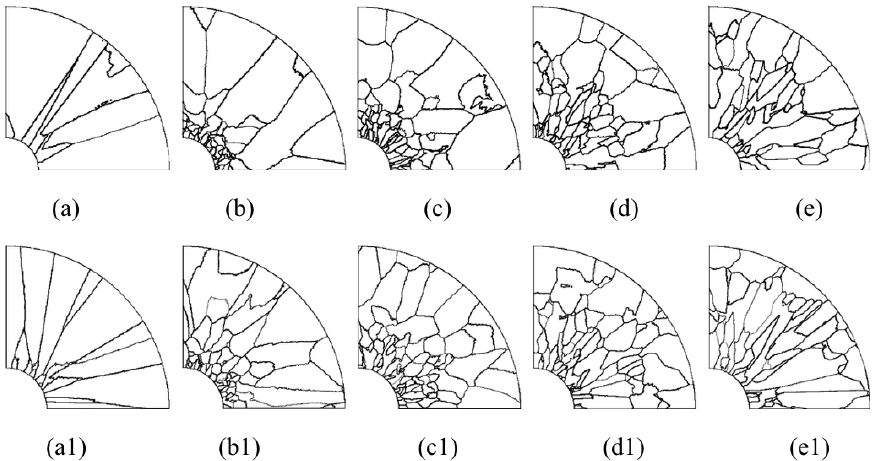
Figure 18. Microstructure morphology predicted of different radial sections with the cooling tem- perature of − 78 °C ( a – e : without nickel coating; a1 – e1 : with nickel coating).